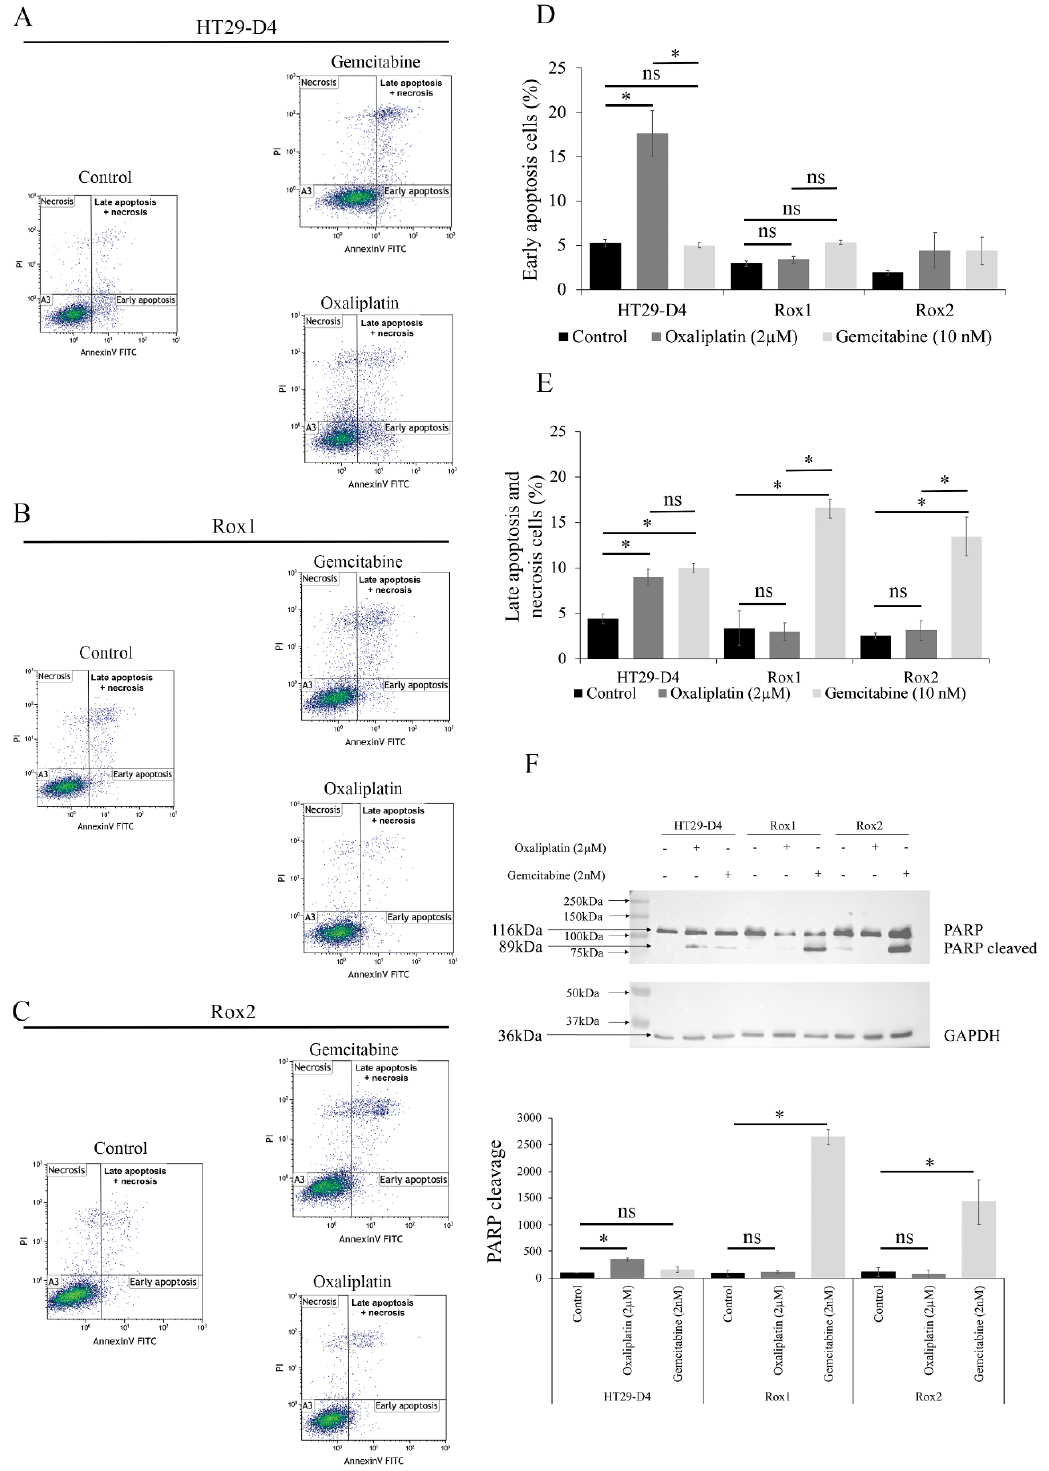
Figure 3. Effects of gemcitabine on the induction of apoptosis. ( A – C ) Representative results of the flow cytometry analysis of annexin-V-FITC and propidium iodide staining (PI) for HT29-D4, Rox1, and Rox2 cells incubated for 48 hours in the presence of oxaliplatin or gemcitabine. ( D , E ) Proportion of cells in early and late apoptosis (expressed as percentages). The values presented are means ± standard errors (error bars) ( n = 3). ( F ) Study of PARP cleavage in HT29-D4, Rox1, and Rox2 cells incubated in the absence or presence of 2 µM oxaliplatin or 2 nM gemcitabine. The Western blots were quantified, and the results are expressed as ratios (cleaved PARP/total PARP; 100% for control condition). Asterisks indicate statistical significance of p < 0.05, ns: not